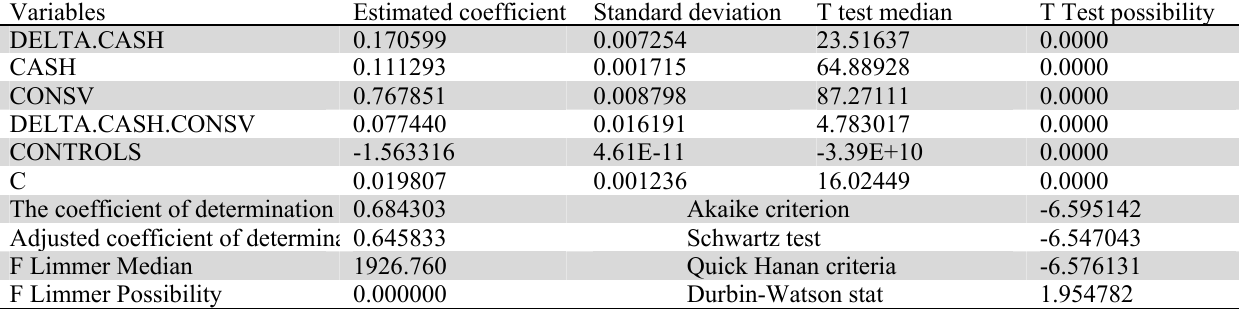
The coefficient of determination